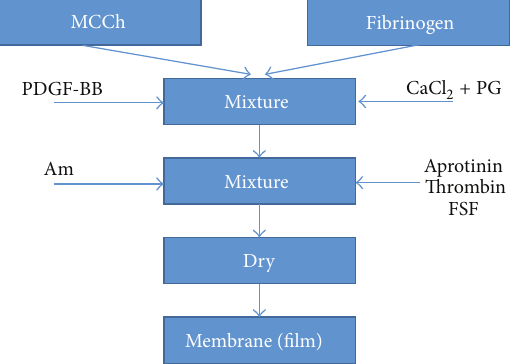
Figure 1: Diagram of the membrane preparation.